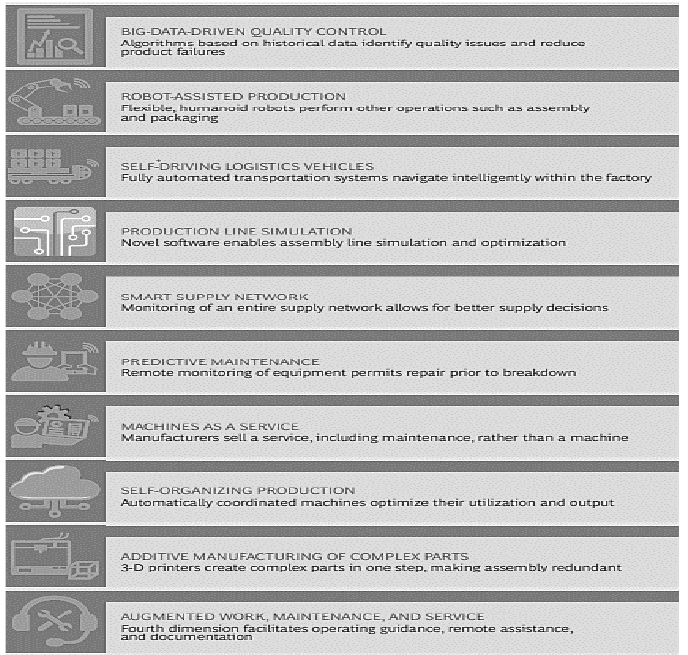
F IGURE 1. EFFECTS OF INDUSTRY 4.0 ON THE